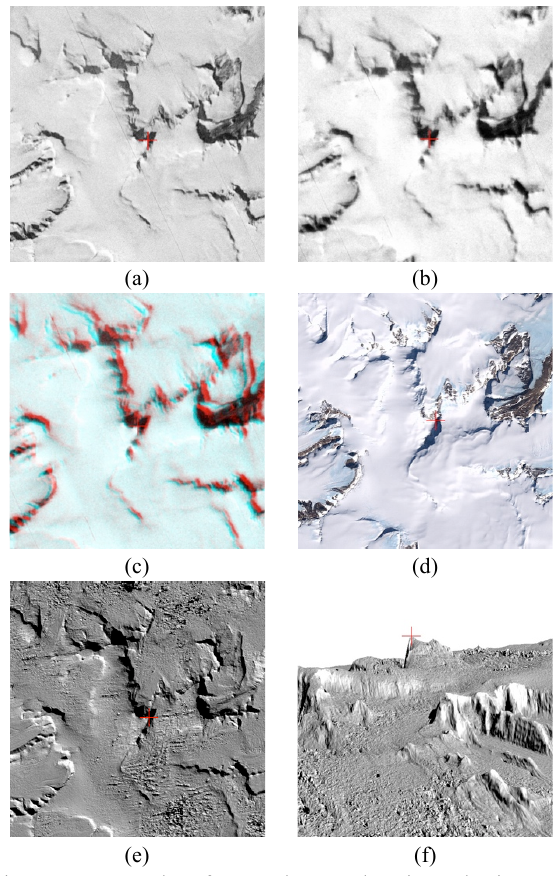
Figure 2. Example of ground control point selection and measurement on ARGON images, LIMA, and shaded relief map generated from ASTER GDEM. (a) and (b) are ARGON stereo- pair; (c) is anaglyph for 3D viewing; (d) is LIMA; (e) is shaded relief map; and (f) 3D view of the shaded relief map draped on DTM. The GCP is selected at the point marked with a red cross.